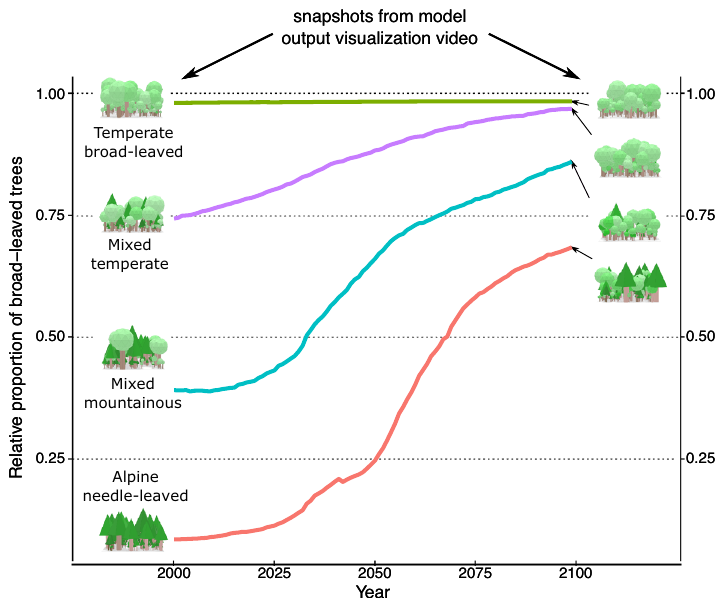
Figure 3. Forest compositions and changes in the proportion of broad-leaved trees (summergreen and evergreen plant functional type combined) under climate change (RCP 4.5) from 2000 to 2099 for each study site. The fraction of broad-leaved trees, as simulated by LPJmL-FIT for each site, increases gradually in almost every forest type reaching at least about 70% by the end of the century. Pictures depict snapshots from visualization of model output in the years 2000 and 2099, respectively. For a full animation of all sites from 2000 to 2099 please see Supplementary Video 1.